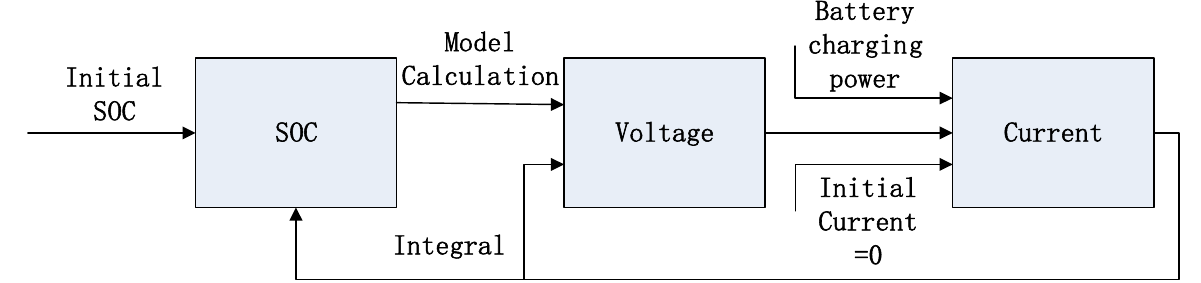
Figure 5. SOC estimation method.